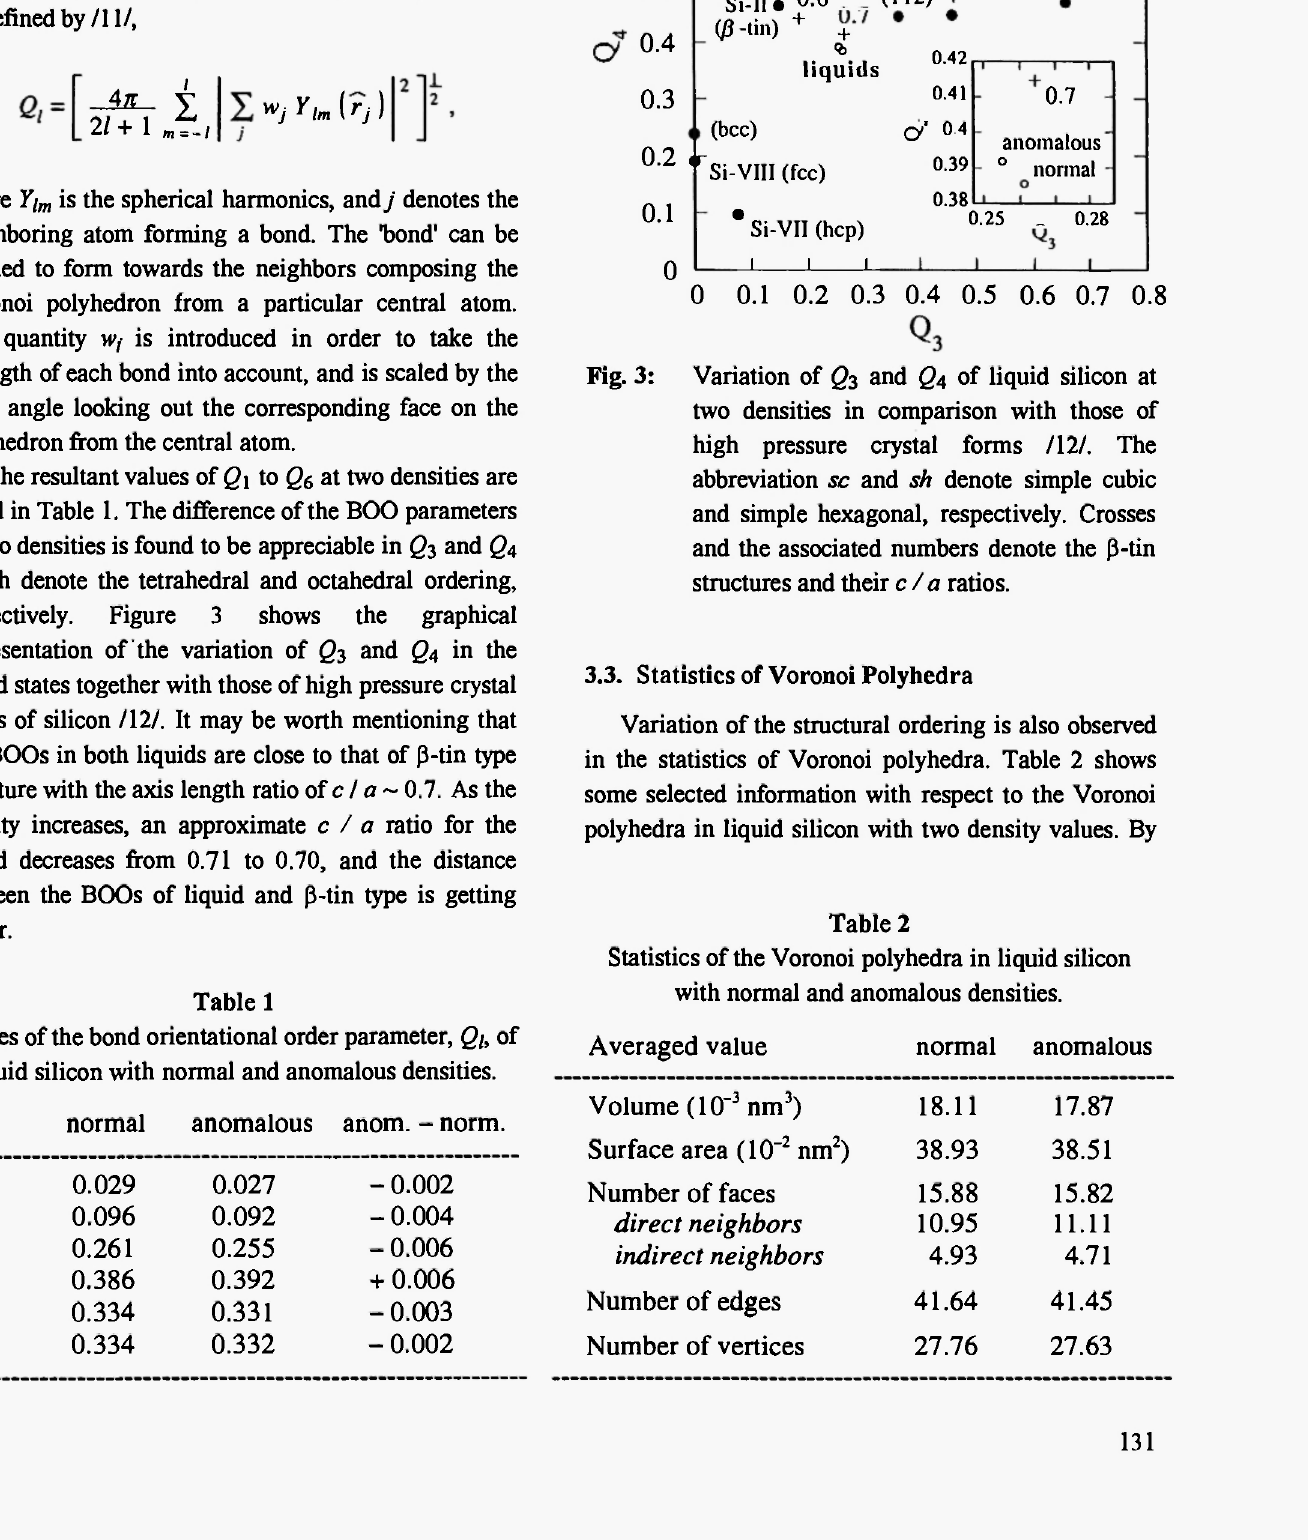
Statistics of the Voronoi polyhedra in liquid silicon with normal and anomalous